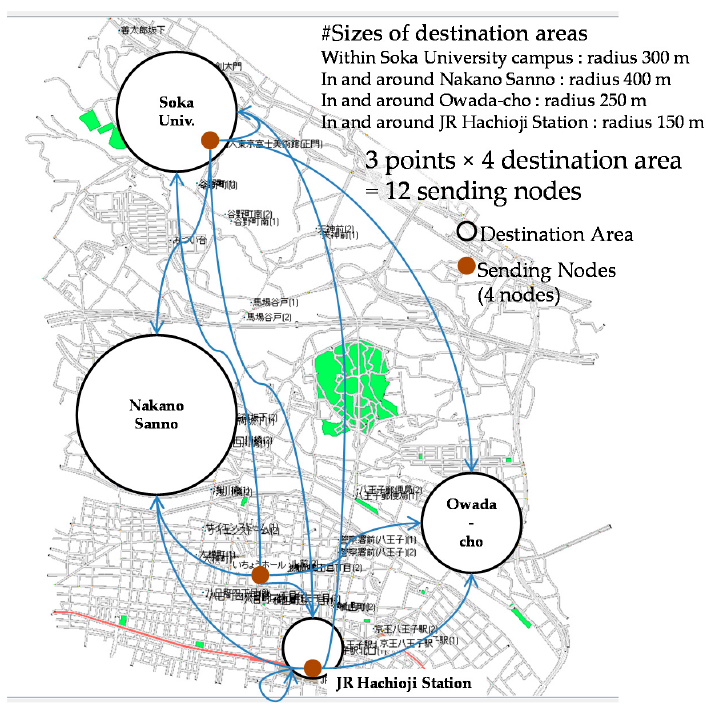
Figure 18. Routes of the traveling nodes and locations of storage points.